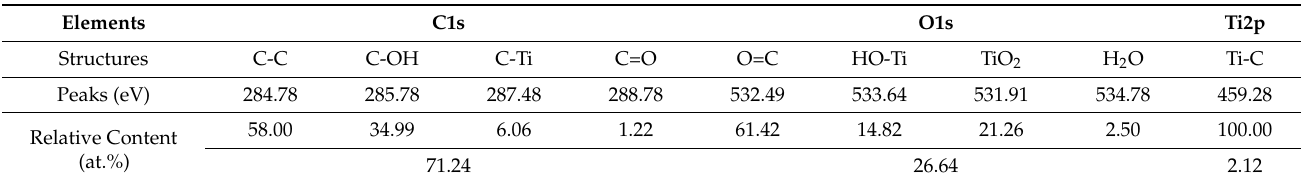
Table 2. XPS binding energy and relative content of each element (C, O, S and Ti) and chemical structures originated from the peak